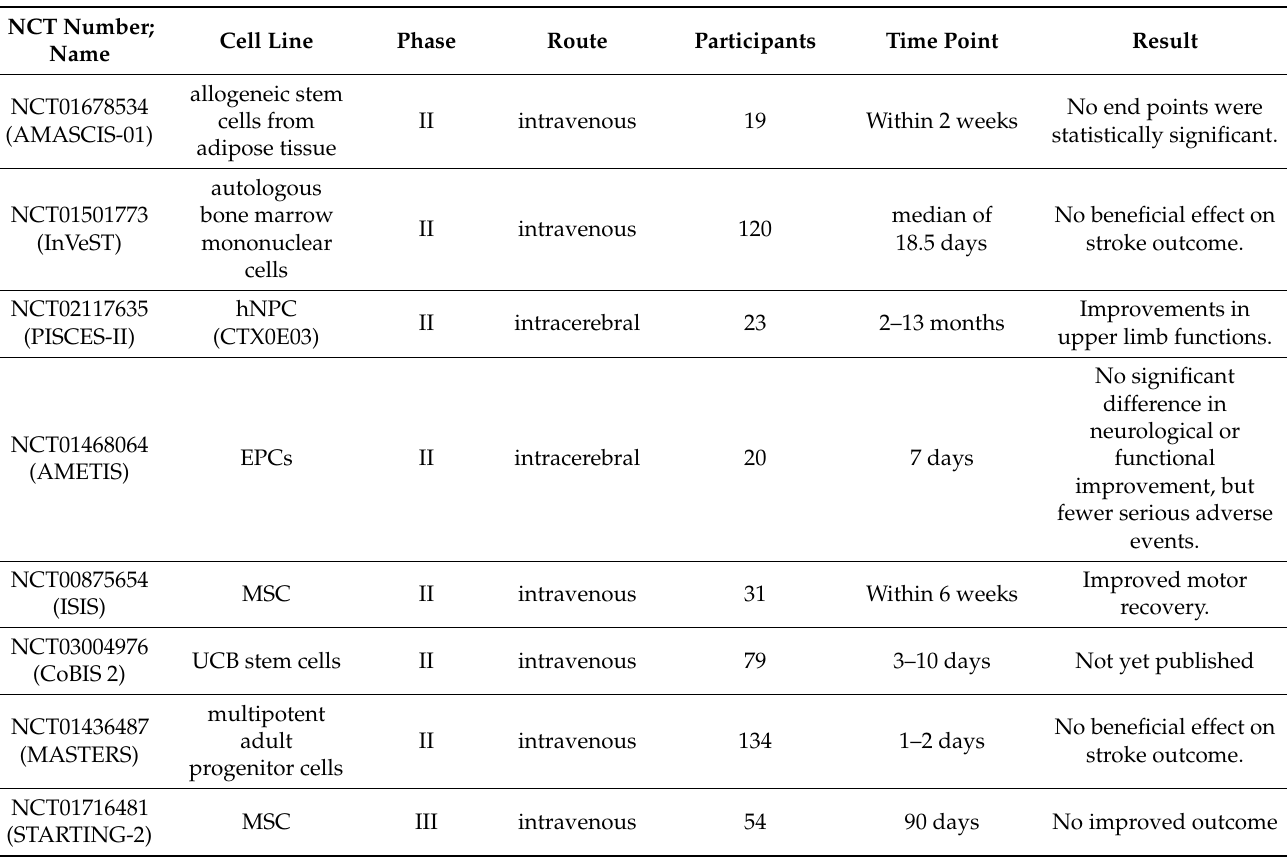
Table 4. Overview of completed clinical trials using stem-cell-based therapies for ischemic stroke treat- ment. Abbreviations: BMSC: bone-marrow-derived mesenchymal stem; EPC: endothelial